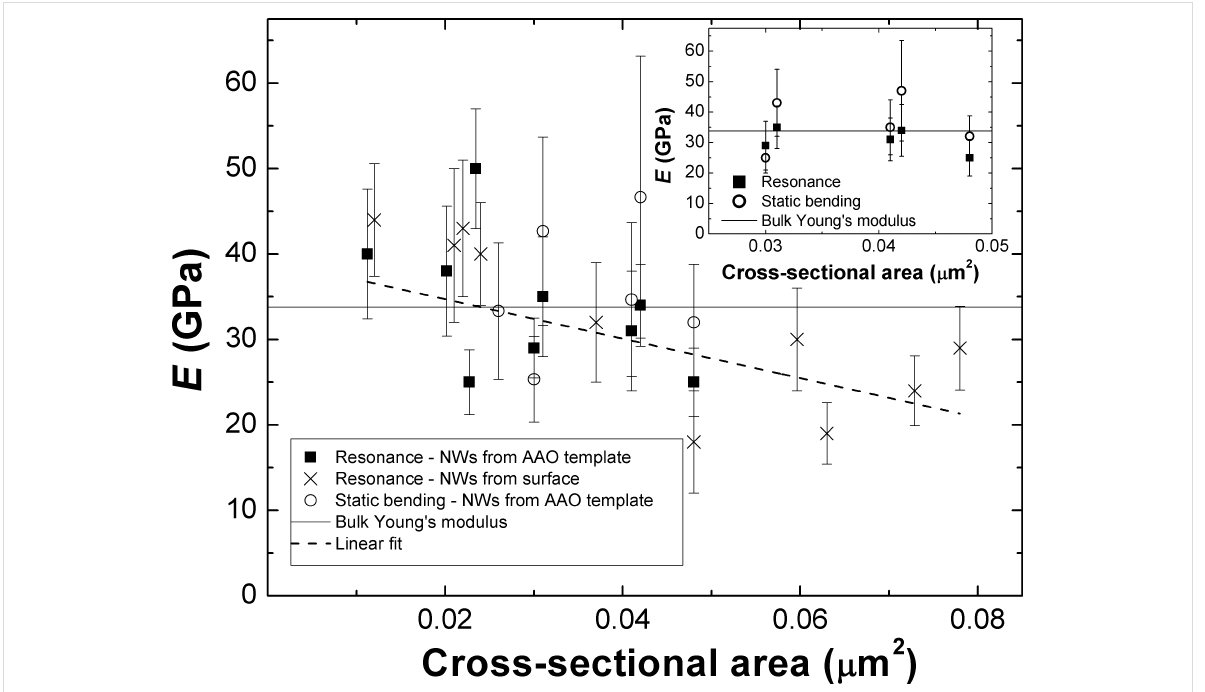
Figure 3: Young’s modulus of Sb 2 S 3 NWs as a function of their size. Data points represent the measured Young’s modulus values determined from mechanical resonance and static bending experiments as a function of NW cross-sectional area. The continuous line at 33.8 GPa is used as an esti- mate for the Young’s modulus of crystalline Sb 2 S 3 in c -axis direction. The dashed line is a linear fit added to experimentally obtained data to highlight the size effect. Inset: Experimentally determined Young’s modulus values of five Sb 2 S 3 NWs using both static bending (circles) and mechanical reso- nance (squares) techniques. Both methods give similar results within experimental accuracy.